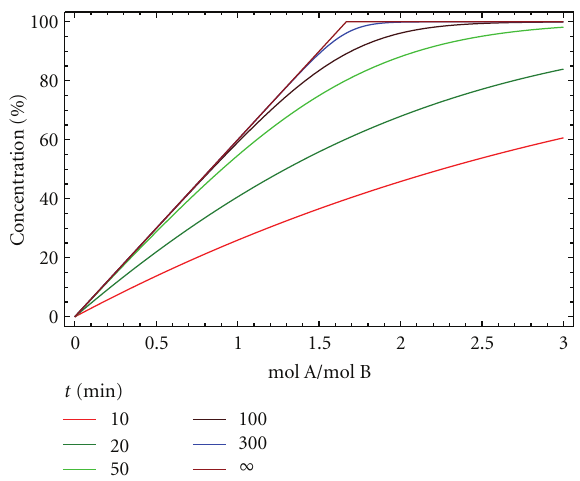
Figure 2: Concentration of the reactants, products, and reaction intermediates versus time for kinetic model 2. [A] 0 = [B] 0 = 0.005 M, k 1 = 10 M − 1 min − 1 and k 2 = 0.5 min − 1 . Figure 3: Yield of macrocycle D versus time for di ff erent initial